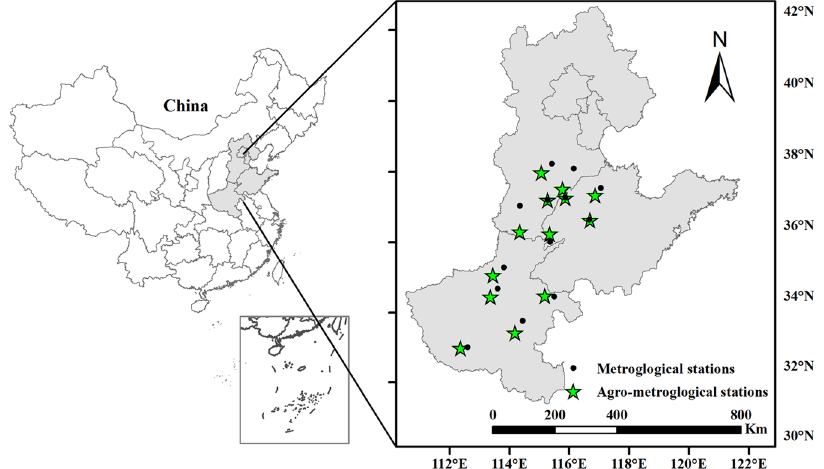
Figure 8. Locations and spatial distribution of the metrological and agro-meteorological stations on the North China Plain. A map of China showing the locations of the three provinces and municipalities within the country (shaded area). Black dots and green pentagrams represent the meteorological and agro-meteorological stations, respectively. Lines indicate province boundaries. Maps were generated using ArcGIS 10.1 (ESRI Inc, Redlands, CA, USA,